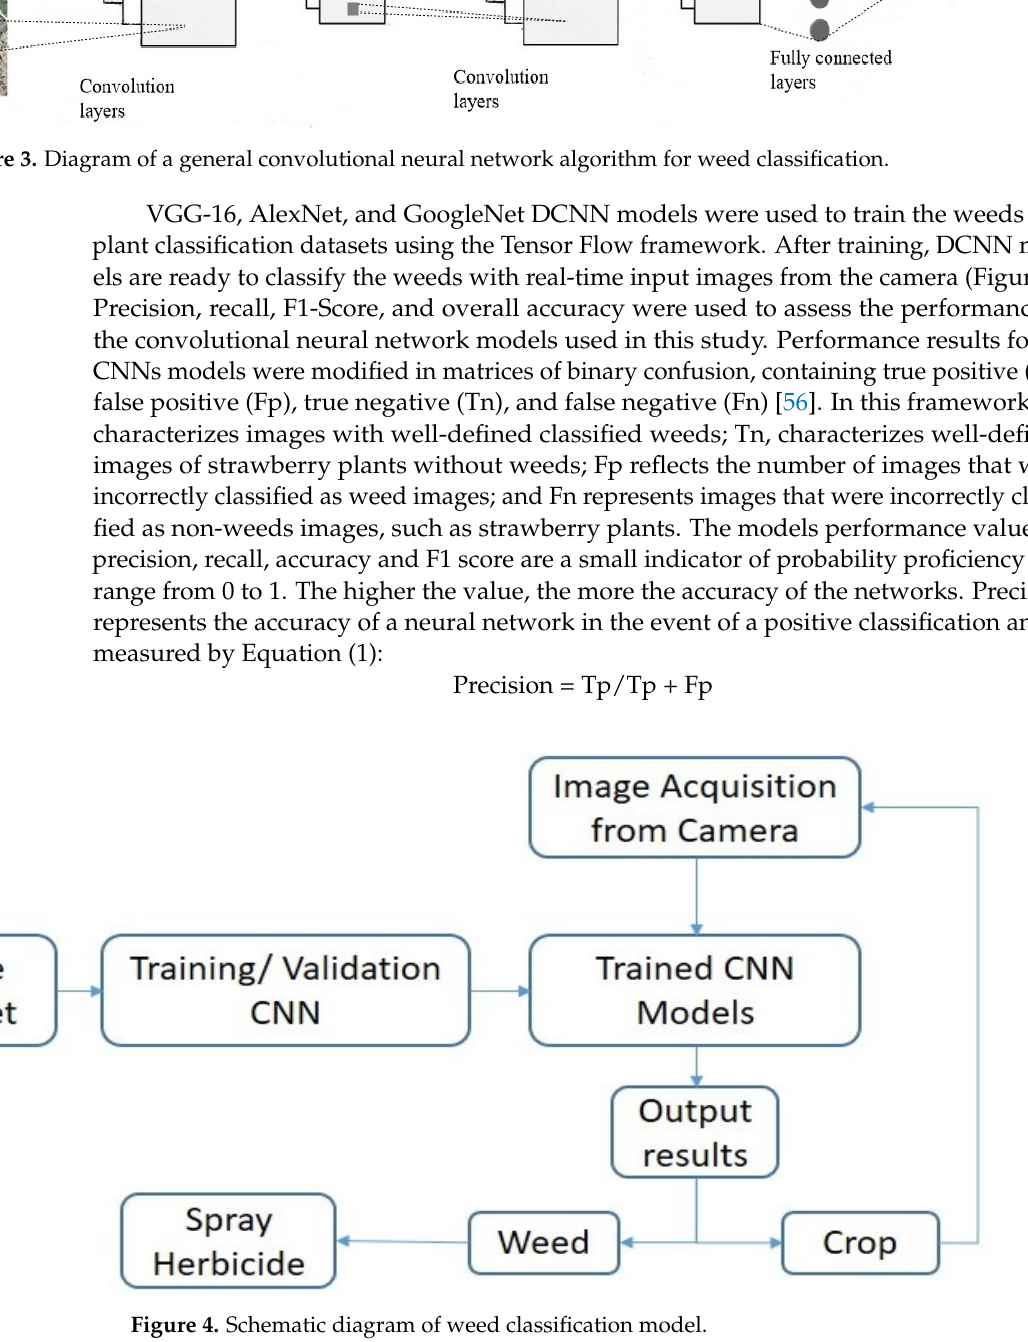
Recall = Tp/Tp + Fn